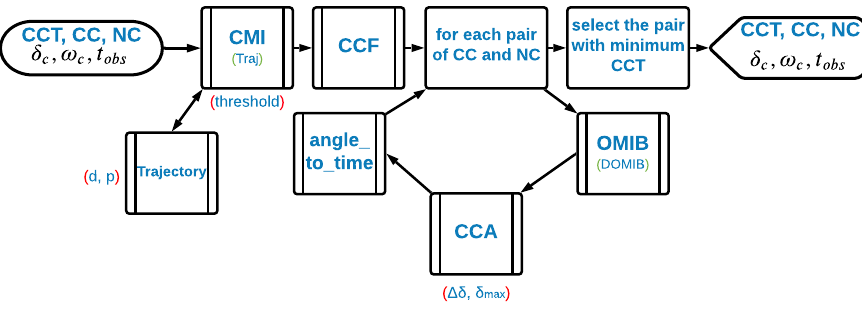
Figure 18. Second refinement scheme to improve the estimation of the CCT.